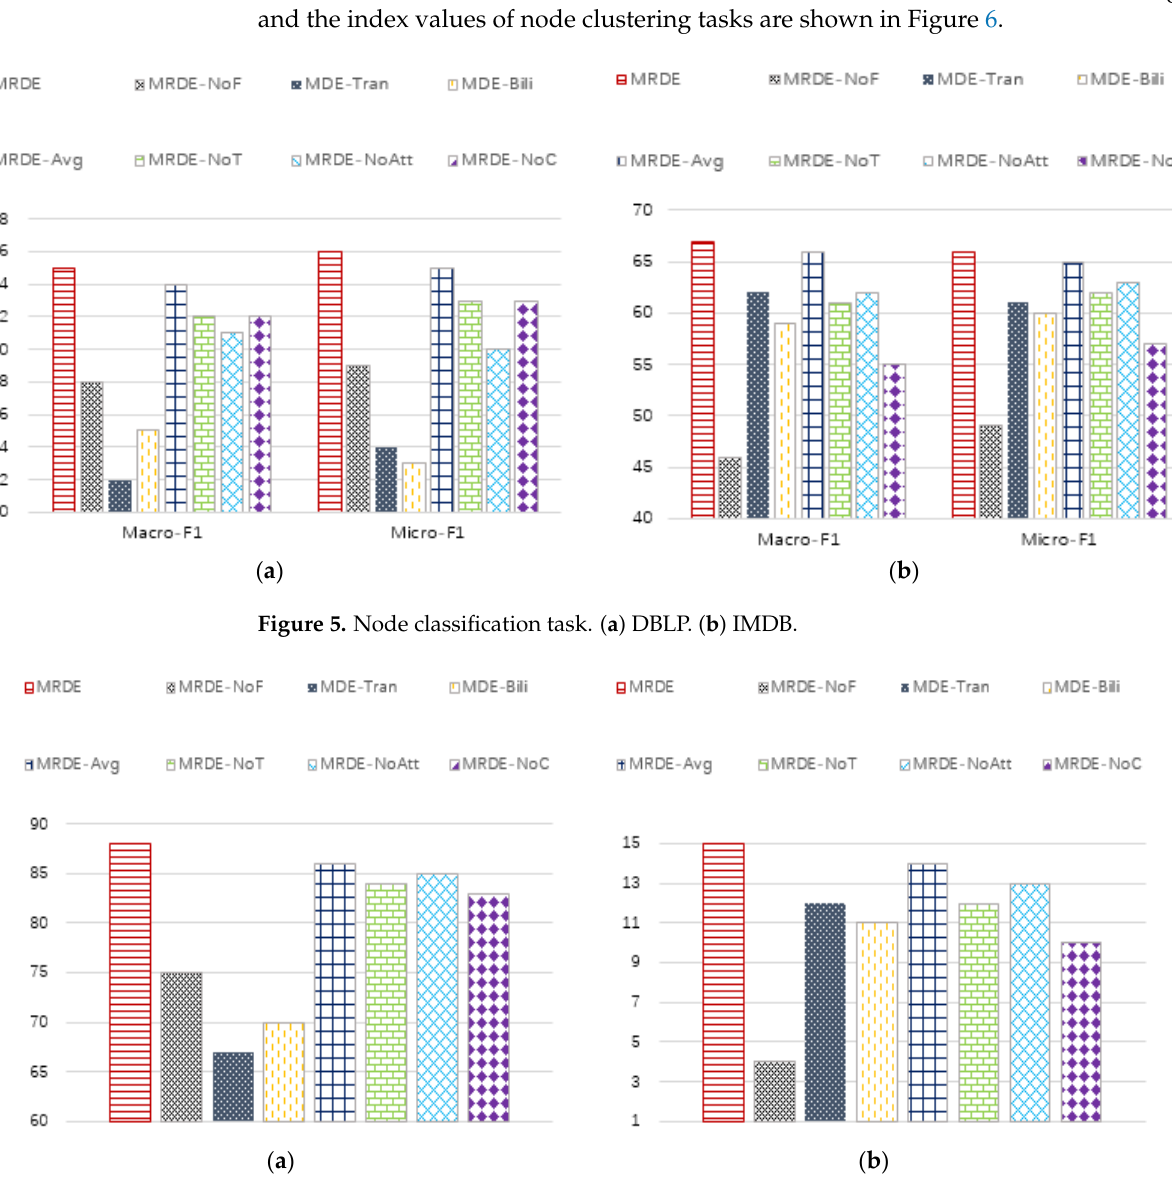
Figure 6. The ARI values of the node clustering task. ( a ) DBLP. ( b )